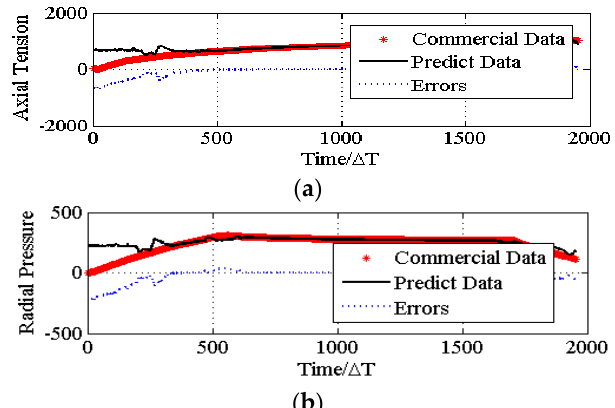
Figure 10. The mechanical properties’ comparison.